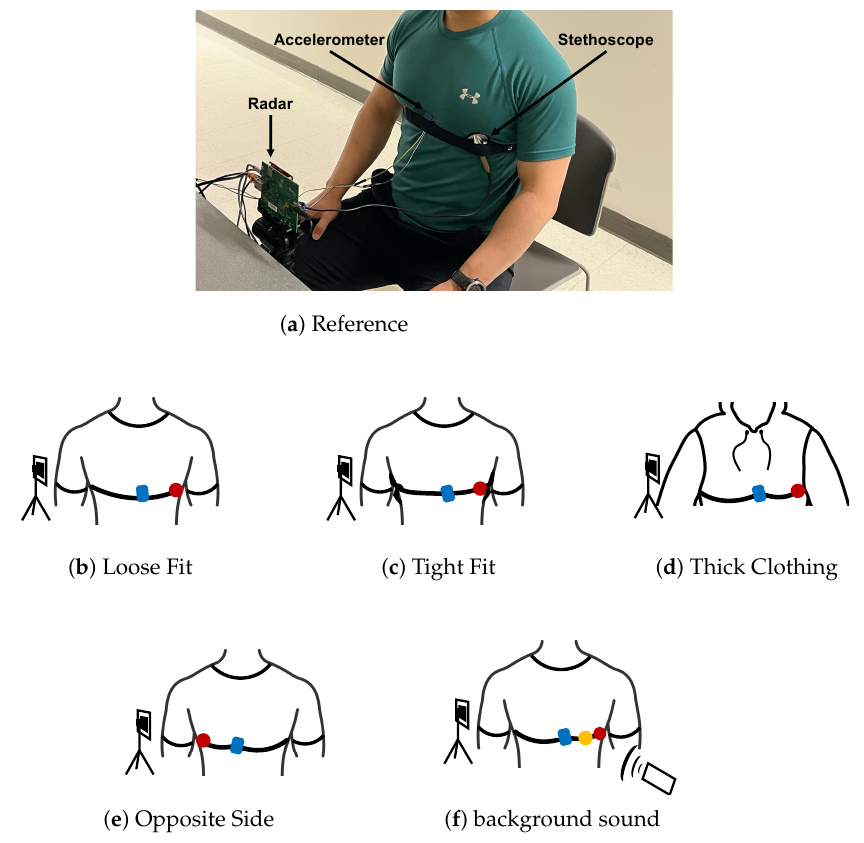
Figure 9. Photograph of the experimental setup under reference conditions with the three measure- ment devices labeled. A depiction of each test case configuration is provided below the photo. The accelerometer is presented in blue, the acoustic stethoscope in red, and the digital stethoscope in